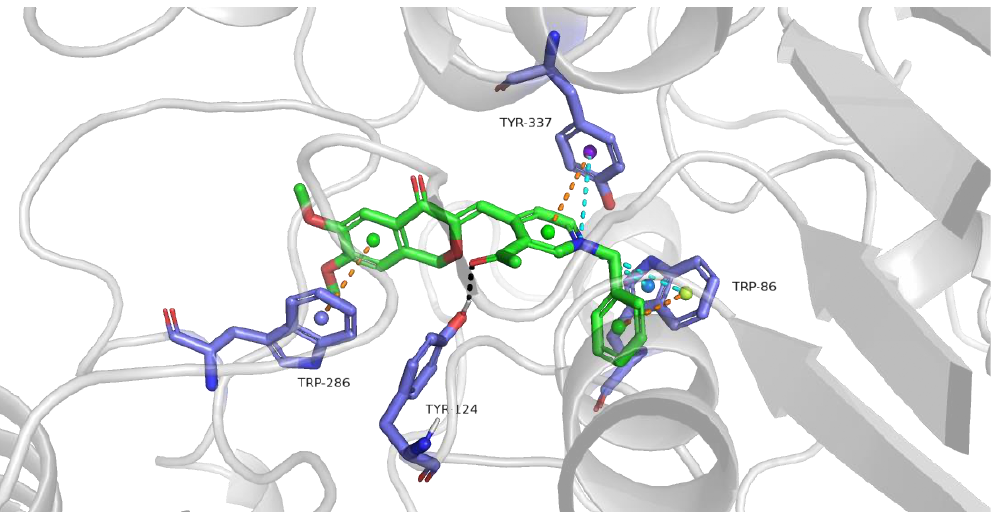
Figure 5. Representative compound 10a interacts with residues in the AChE pocket. The hydrogen bonds of ligand with the target are shown by black-dashed line, π - π interaction is shown by brown- dashed line, π -cations interaction is shown by blue-dashed line.